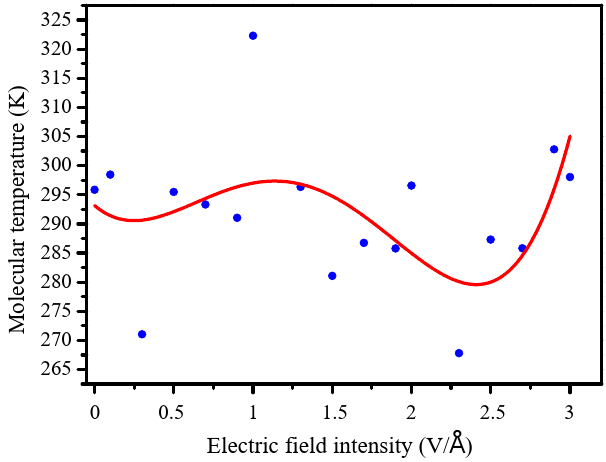
Figure 7. Changes of molecular internal temperature.